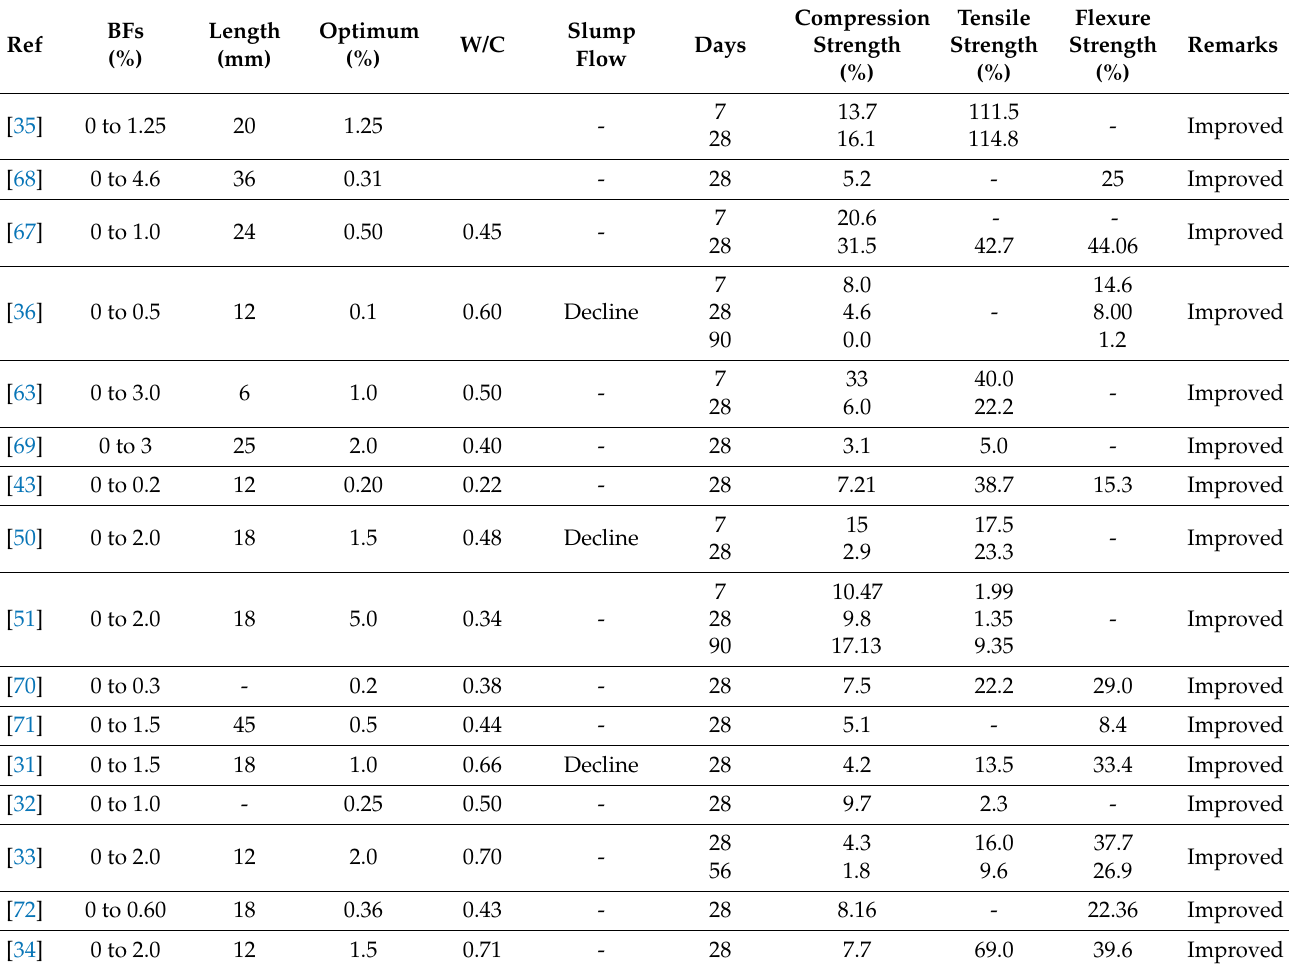
Table 2. Summary of Strength Properties of Concrete with